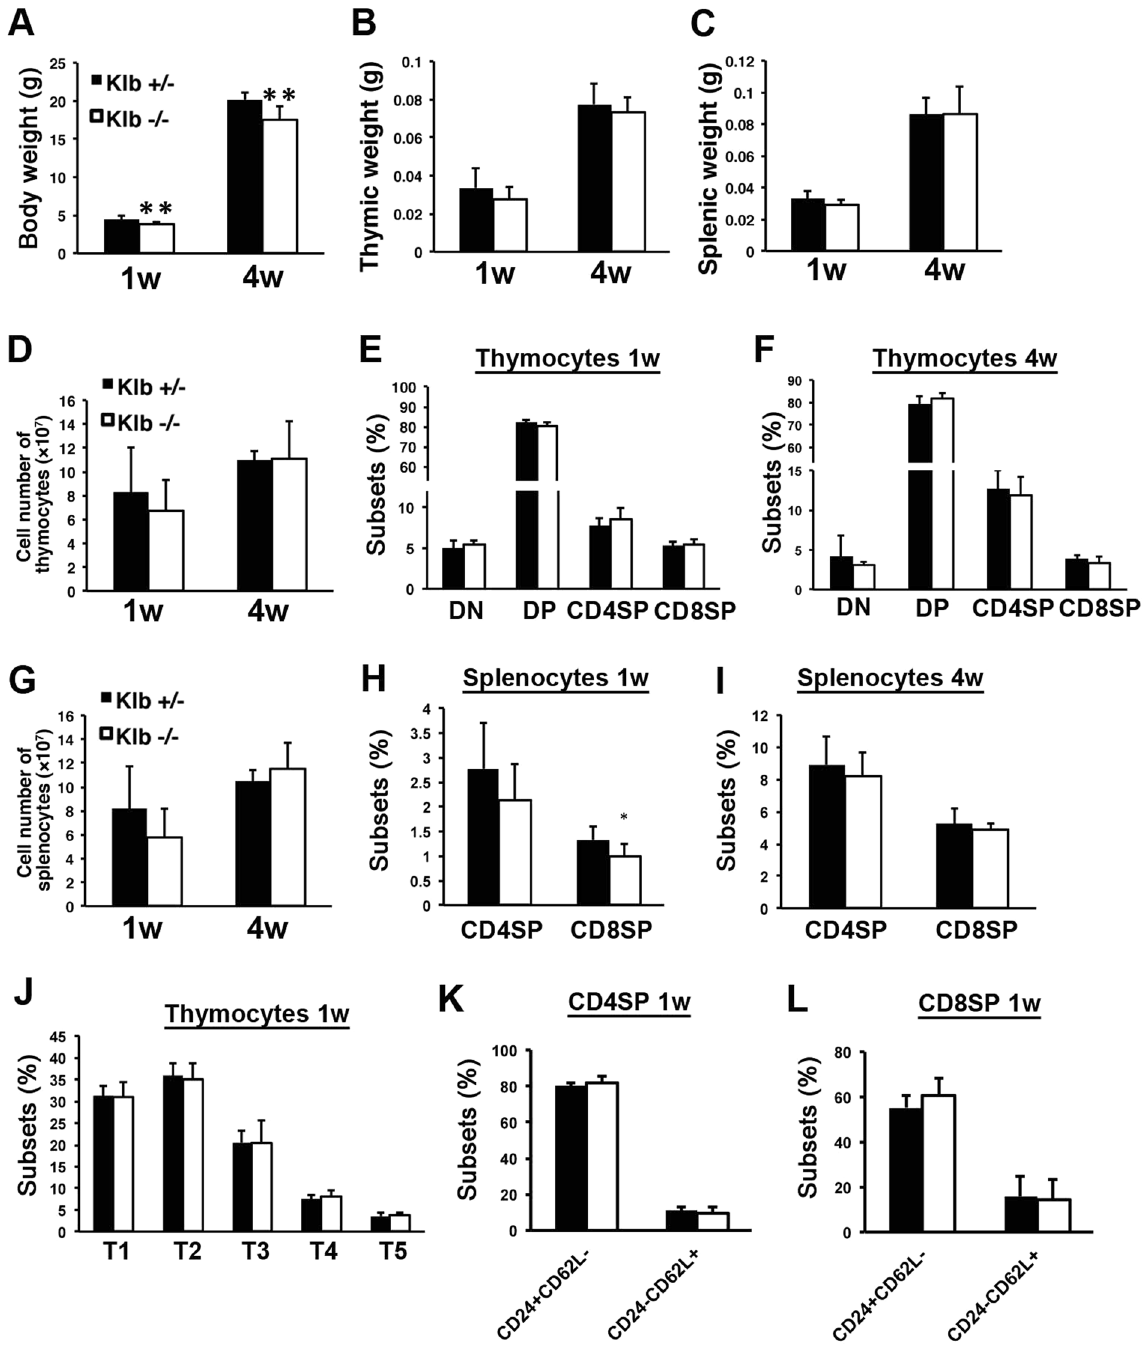
Figure 5. Klb is not involved in the development of thymocytes. ( A–C ) Body, thymic, and splenic weights of 1- and 4-week-old Klb + / − and Klb − / − mice. Klb − / − mice showed decreased body weight compared to Klb + / − mice. ( D and G ) Cell numbers of enzymatically digested suspensions from thymi and spleens were counted. ( E,F,H and I ) Thymocytes and splenocytes from 1- and 4-week-old Klb + / − and Klb − / − mice were stained with anti-CD4 and anti-CD8 mAb. Charts show the percent of DN, DP, CD8SP, and CD4SP from 1- and 4-week-old Klb + / − and Klb − / − mice. ( J ) Thymocytes from 1-week-old Klb + / − and Klb − / − mice were defined by TCR β and CD69 levels and subdivided into 5 subsets. Charts show the percentage of the 5 subsets from 1-week-old Klb + / − and Klb − / − mice. ( K and L ) Charts show the percentage of CD24 + CD62L − immature and CD24 − CD62L + mature SP subsets from gated CD4SP ( K ) and CD8SP cells ( L ) of 1-week-old Klb + / − and Klb − / − mice. All data shown are the mean ± SD from ≧ 8 mice per genotype. * P < 0.05, * P < 0.01 versus Klb + / −